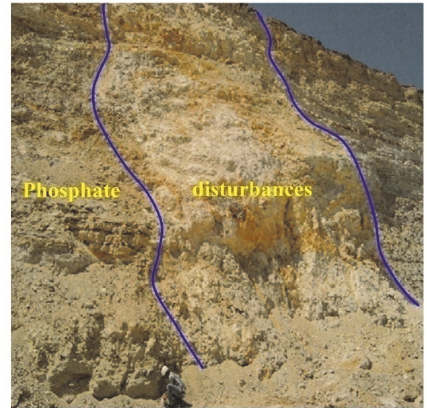
Figure 2: Geological sections showing disturbed phosphate series in Sidi Chennane